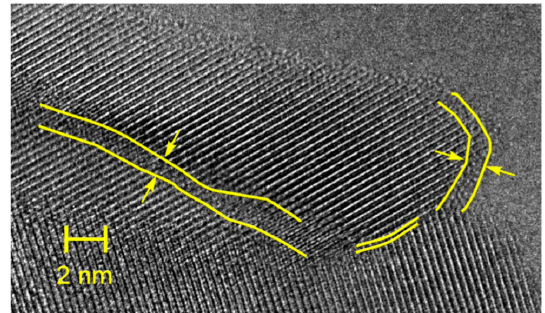
Figure 11. Magnification of a fragment of the HR-TEM image of a LiFe 0.5 V 0.20 PO 4 (denoted as G20) specimen heated up to 493 ◦ C. Visible are nanosize grains and interfacial regions around them (some of them marked) (Reproduced with permission from ref. [47]. Copyright 2017, Elsevier).